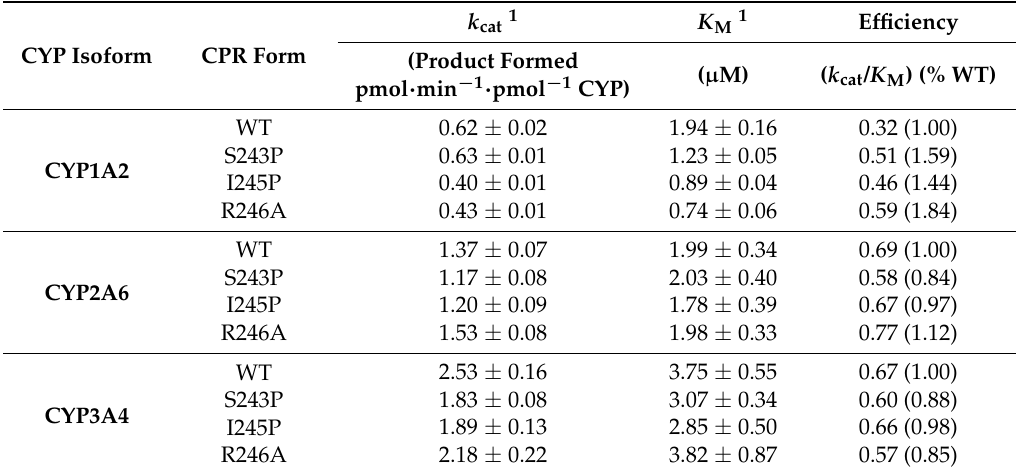
Table 3. Michaelis-Menten kinetic parameters of CYP